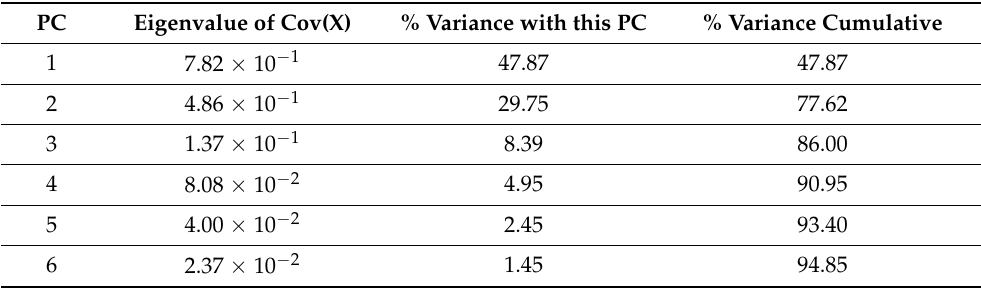
Figure A5. Scores and loadings plots for XRD PCA ( A ) Scores for PC3 v. samples; ( B ) Loadings for PC3 v. mineral phases; ( C ) Scores on PC4 v. samples; ( D ) Loadings for PC4 v. mineral phases. Table A2. Table displaying eigenvalue, %variance captured and % cumulative variance captured for every PC.